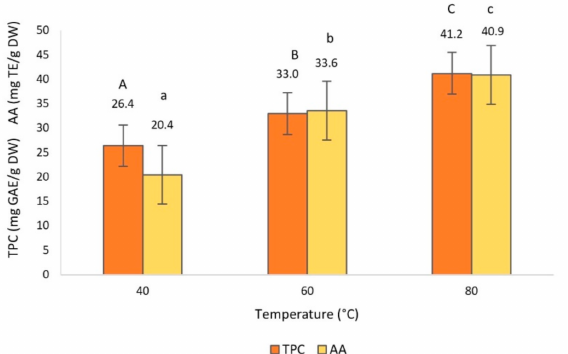
Figure 3. Total phenol content (TPC) and antioxidant activity (AA) of olive leaf extract obtained by microwave-assisted extraction (MAE), as a function of the extraction temperature. Different capital and lowercase letters above the bars represent groups significantly different at p < 0.05 of TPC and AA, respectively.